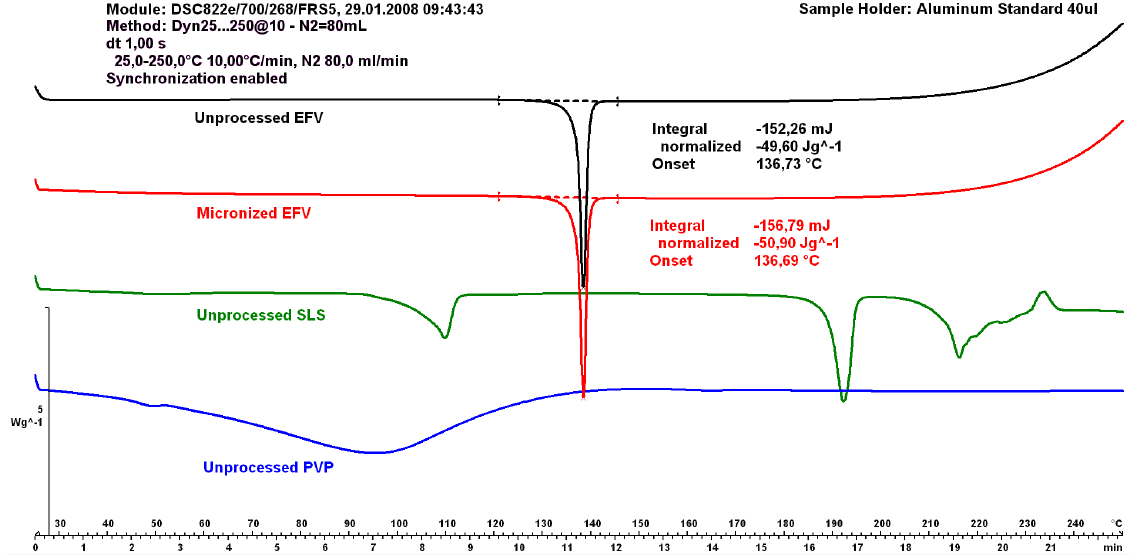
Figure 6. Differential scanning calorimetry (DSC) curves of unprocessed efavirenz, micronized efavirenz, unprocessed SLS and unprocessed PVP.